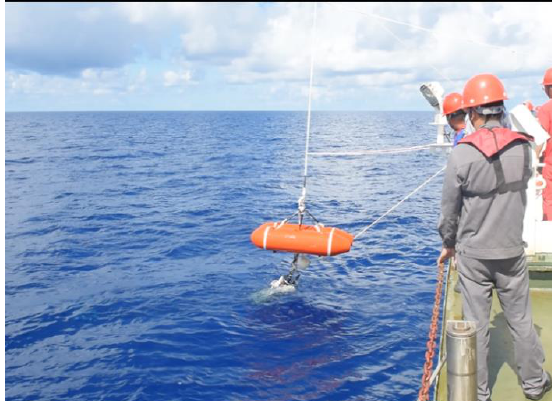
Figure 6. Sea trial site.